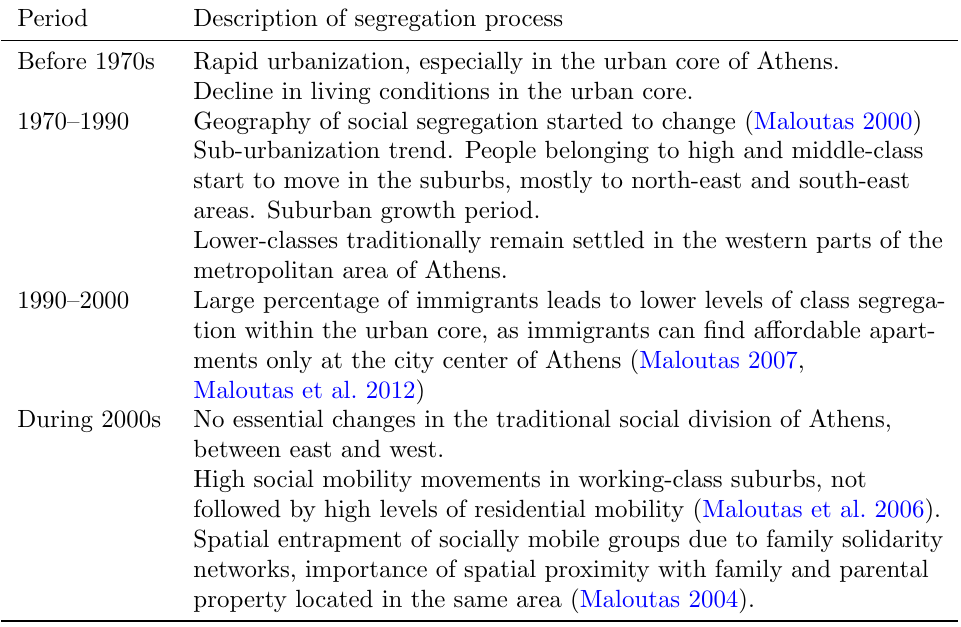
Table 1: Evolution of the spatial socio-economic segregation process within the metropoli- tan area of Athens (Maloutas